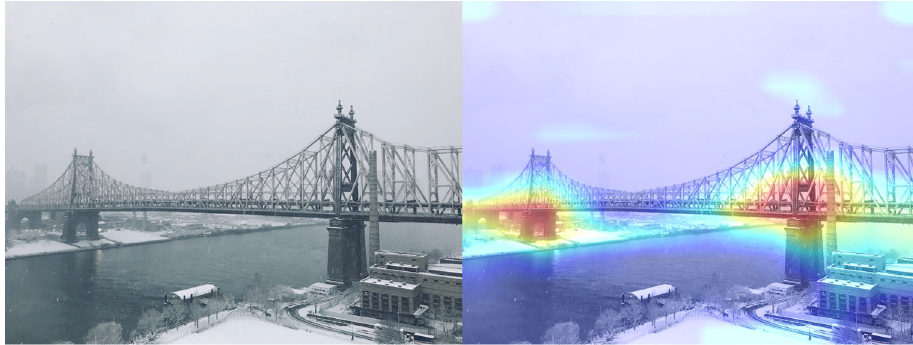
Fig. 14 An example of a class activation map (CAM) [58]. A CNN network trained on ImageNet classified the left image as a B bridge pier ^ . A heatmap for the category of B bridge pier ^ , generated by a method called Grad-CAM [59], is superimposed (right image), which indicates the discriminativeimage regions used by the CNN for the classification